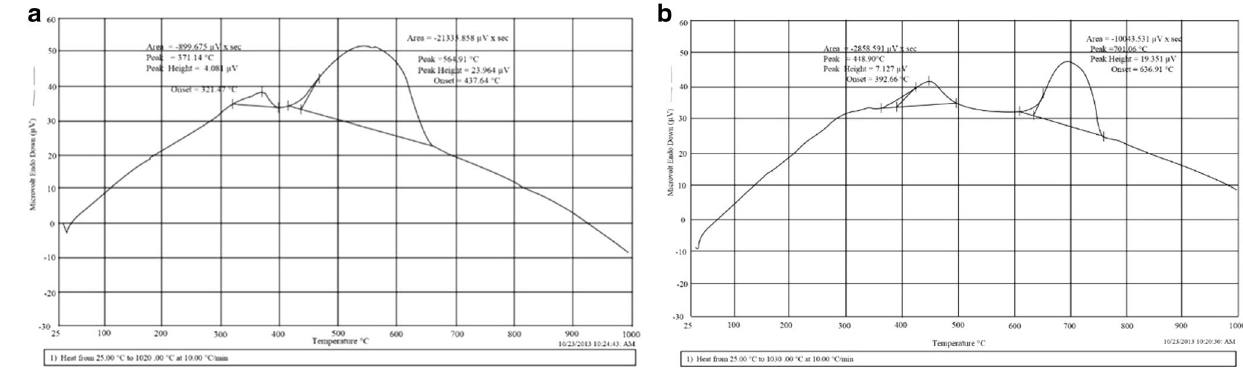
Fig. 5 TGA analysis of a before accumulation and b after accumulation of soya waste-based adsorbent in nitrogen atmosphere